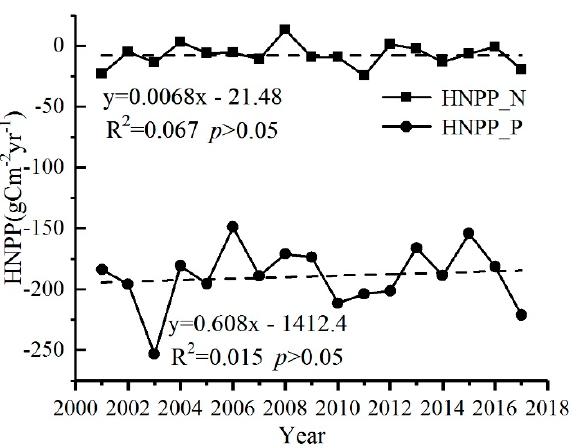
Figure 12. Changes in the annual average values of HNPP_N and HNPP_P from 2001 to 2017.